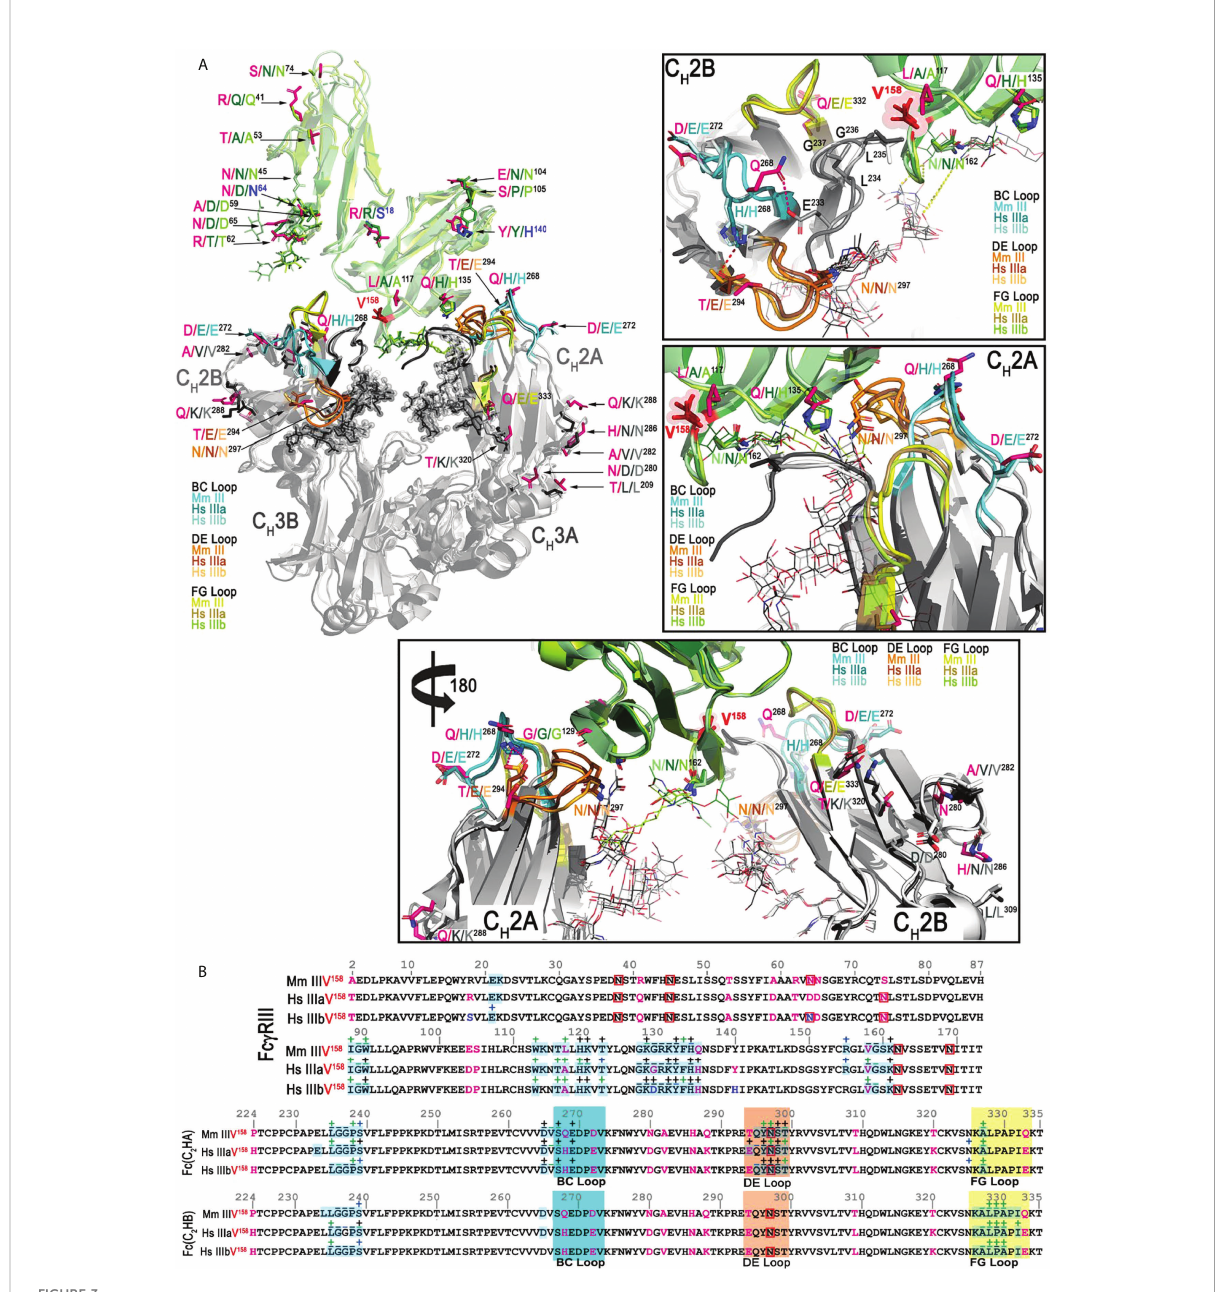
FIGURE 3 Structural comparison of the macaque Fc g RIII(Val 158 )-Fc(IgG1) complex with the two human Fc g RIIIa/b(Val 158 )-Fc(IgG1) complexes (PDB: 5XJE and 6EAQ, respectively). (A) Superimposition of the structures and the interfaces of the Mm Fc g RIII(Val 158 )-Fc(IgG1) and the two Hs Fc g RIIIa/b (Val 158 )-Fc(IgG1) complexes shown in a ribbon diagram with colors indicated as in Figure 1. The three panels on the right and bottom are the blow up views of the interfaces of the complexes. The two Fc monomers are labeled as A and B chains. Residues of Mm Fc g RIII-Fc complex that differ from the Hs complexes are colored in magenta. Residues of the two Hs Fc g RIIIa/b-Fc(IgG1) complexes are shown in lighter and darker color shades, respectively. Residues in the Hs Fc g RIIIb-Fc(IgG1) complex that differ from the Hs Fc g RIIIa-Fc(IgG1) complex are highlighted in blue. The BC, DE and FG loops of the Mm Fc g RIII-Fc complex are colored in cyan, orange and yellow, respectively. BC, DE, FG loops of the two Hs Fc g RIII-Fc(IgG1) complexes (Hs Fc g IIIaVal 158 and Hs Fc g IIIbVal 158 ) are colored in darker and lighter shades of cyan, orange and yellow (in respect to the colors of the Mm Fc g RIII-Fc(IgG1) complex), respectively. The same color scheme is applied to the remaining panels. (B) Pairwise sequence alignment of the Fc g RIII receptors (top panel) and Fc(IgG1) (bottom panel) in the Mm Fc g RIII(Val 158 )-Fc and the two Hs Fc g RIIIa/b (Val 158 )-Fc(IgG1) complexes. Glycosylated residues are in red boxes. Buried surface residues are determined by PISA and are shaded in blue. Contact residues de fi ned by a 5 Å cutoff are marked above the sequence with (+) for side chain and (-) for main chain to indicate the type of contact. Contact types are colored as follows: hydrophilic (green), hydrophobic (blue) and both